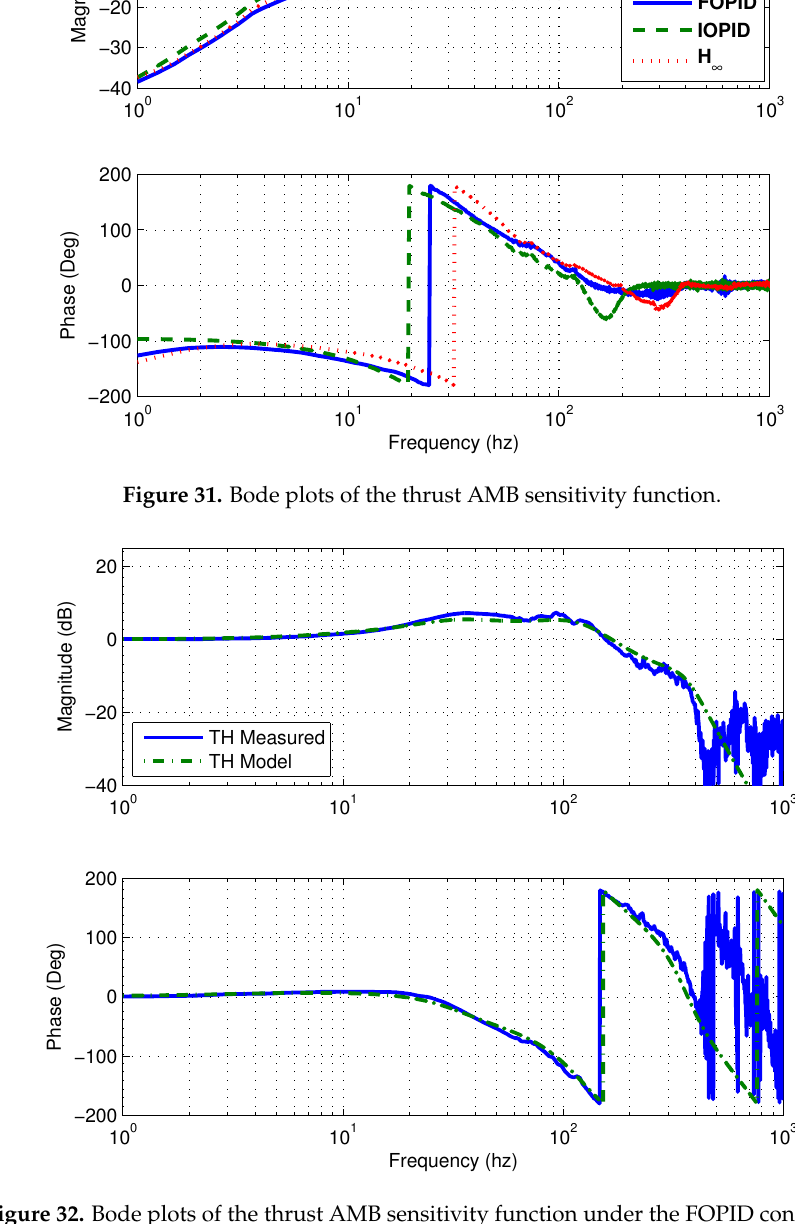
Figure 32. Bode plots of the thrust AMB sensitivity function under the FOPID